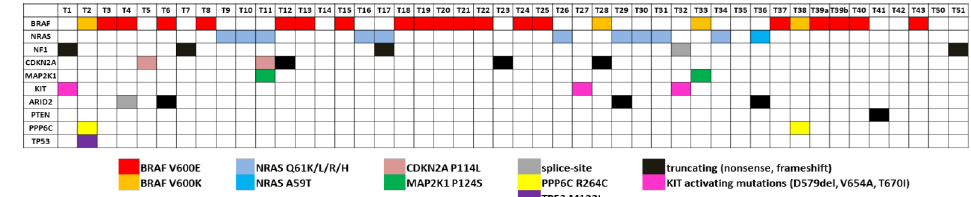
Figure 4. Somatic variants with clinical significance. The clinically relevant variants identified by WES or targeted sequencing in melanoma samples ( n = 46) are shown. Different colours indicate specific variants, as shown at the bottom of the